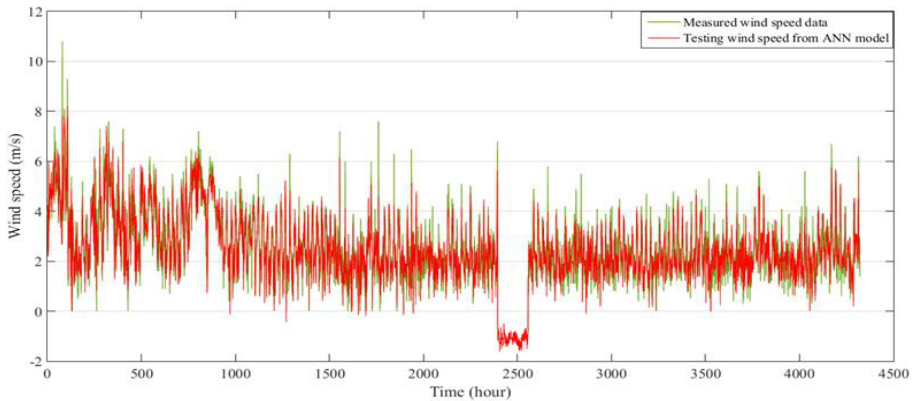
Figure 14. Comparison between measured and predicted hourly wind speed data for six months at Mersing, for validation of the ANN model.